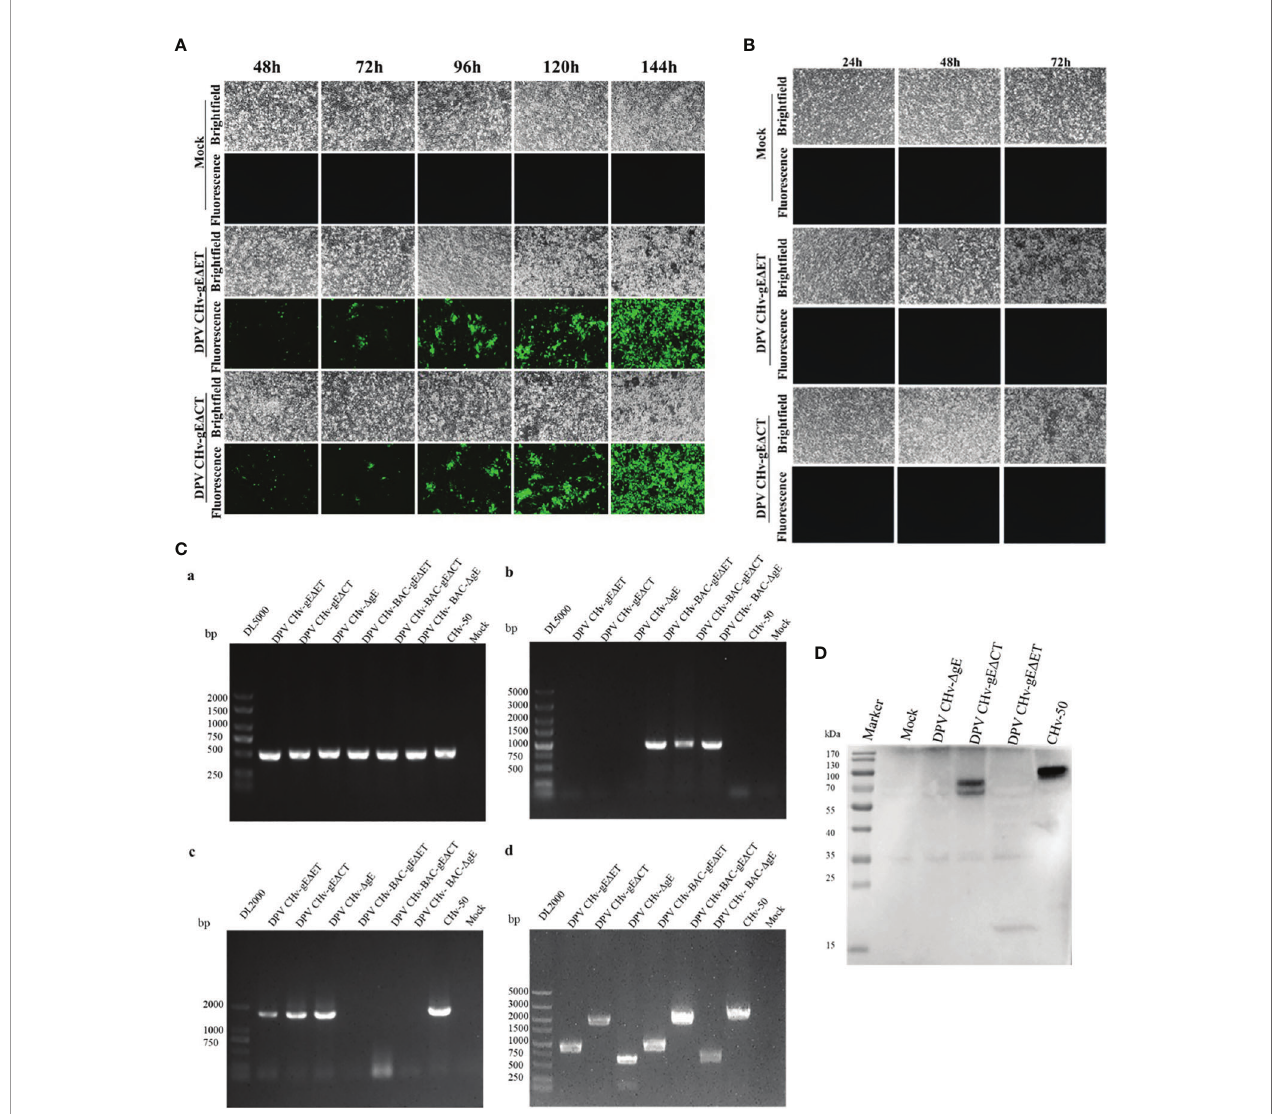
FIGURE 2 | Generation and identi fi cation of mutant viruses for DPV CHv-gE D ET and DPV CHv-gE D CT. (A) Transfection of the plasmids DPV CHv-gE D ET-GS1783/DPV CHv-gE D CT-GS1783 into DEFs resulted in numerous fl uorescent spots and cytopathies, the mutant virus DPV CHv-gE D ET/DPV CHv-gE D CT were rescued. (B) Cells with cytopathic but no fl uorescent spots were picked into new DEFs, resulting in the non- fl uorescent mutant virus. (C) PCR identi fi cation of mutant viruses: (a) UL30 gene identi fi cation primer, (b) BAC identi fi cation primer, (c) UL23 gene identi fi cation primer, (d) gE gene deletion identi fi cation primer. (D) DEFs were infected with DPV CHv- D gE, DPV CHv-gE D CT, DPV CHv-gE D ET, and DPV CHv-50, and an anti-gE polyclonal antibody was used for